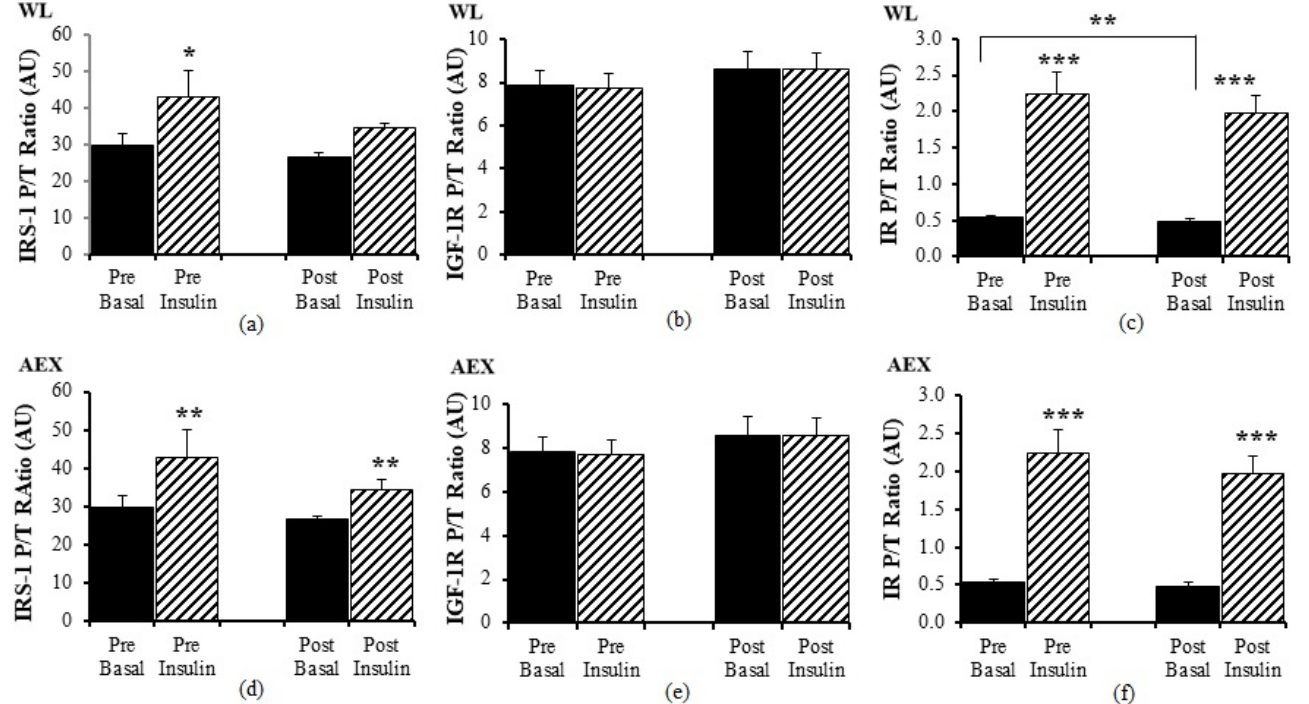
Figure 4. Skeletal muscle IRS-1, IGF-1R and IR phosphorylation, and total protein expression ratio during basal (solid) and insulin-stimulated (striped) pre and post WL ( a – c ) and AEX ( d – f ). Paired t -tests between pre basal vs. pre insulin, post basal vs. post insulin, and pre vs. post basal analyses within WL and within AEX were performed using the SPSS software version 27 (SPSS Inc, Chicago, IL, USA). * p ≤ 0.05; ** p ≤ 0.01; *** p ≤ 0.001.